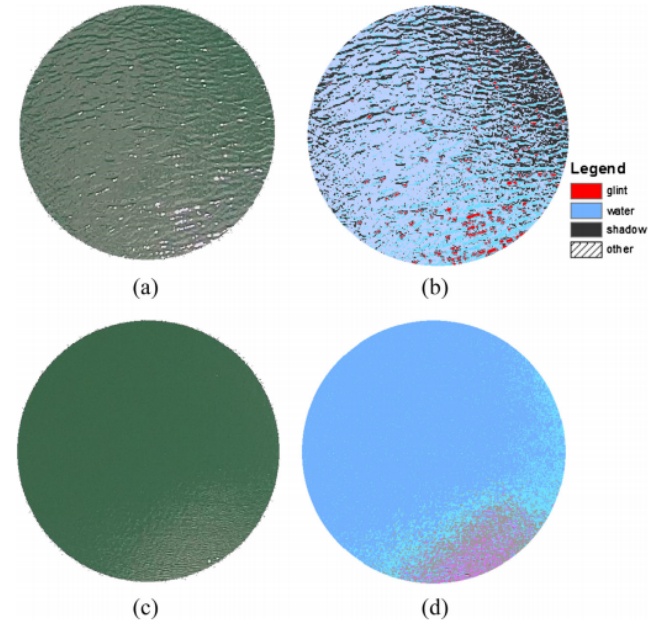
Figure 18. Surface sun glint